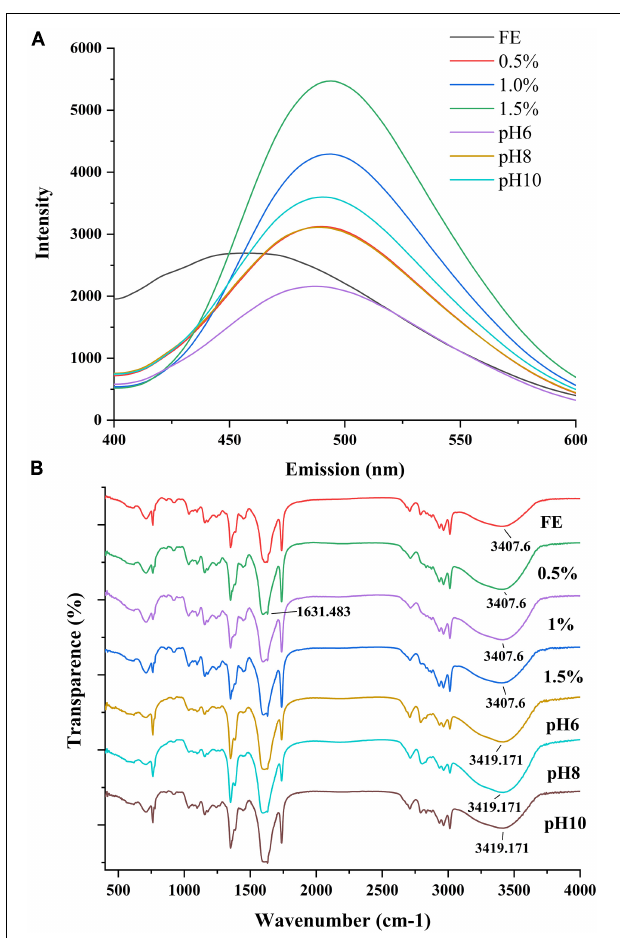
FIGURE 5 | Surface hydrophobicity (A) and FTIR (B) of complex